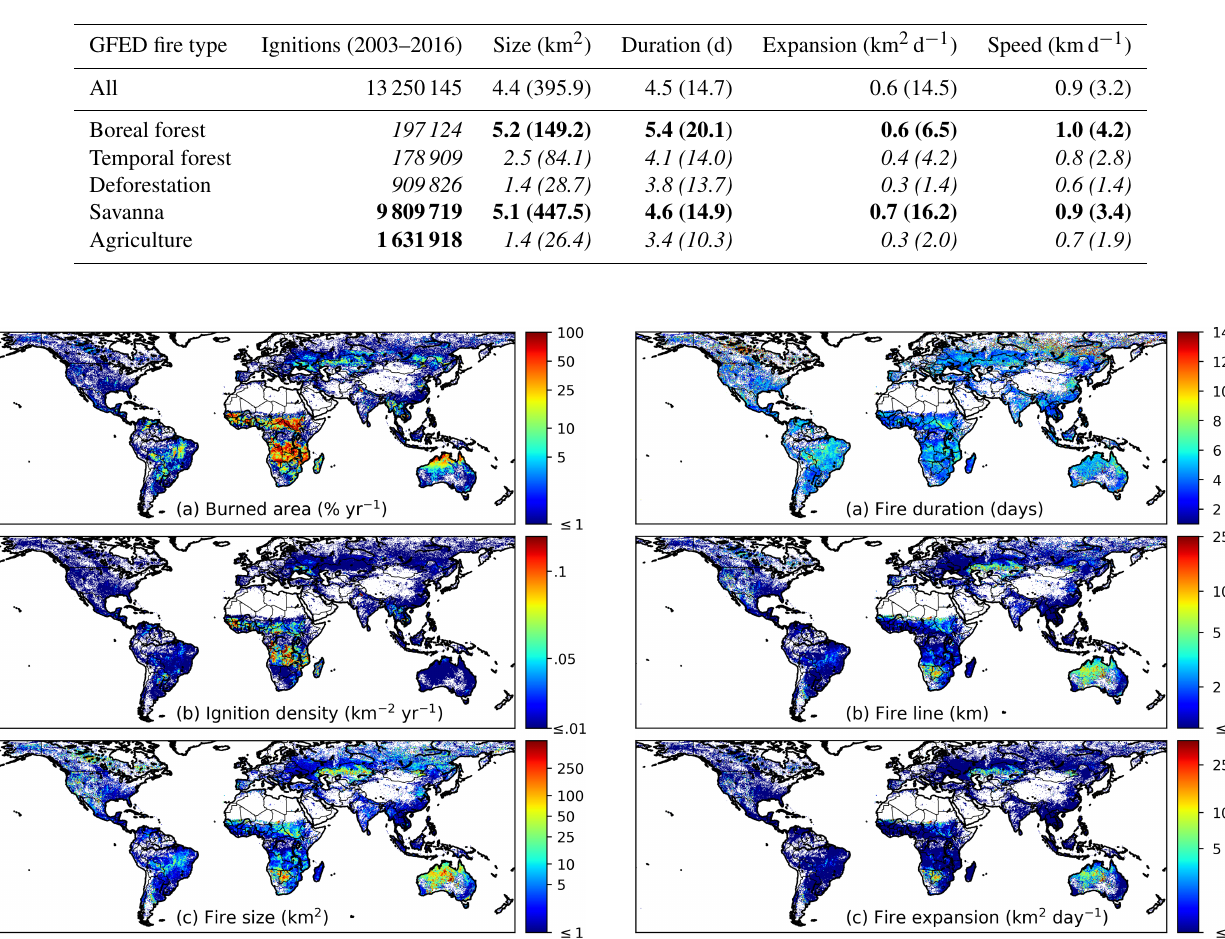
Table 2. Fire attributes by GFED fire type during 2003–2016. Ignitions are the summed ignitions over the study period (2003–2016). For size, duration, expansion and speed we report the mean values for individual fires and also the mean weighted by fire size (the latter estimate is provided in parentheses). For agriculture, we only included fires with greater than 90% of burned area classified as cropland. For ignitions, fire types with over a million ignitions are shown in bold font and lower values in italic font. For other fire aspects, values equal to or above the global average are shown in bold font and below the global average in italic font. A map of the GFED fire types is shown in Appendix B (Fig. B3b).